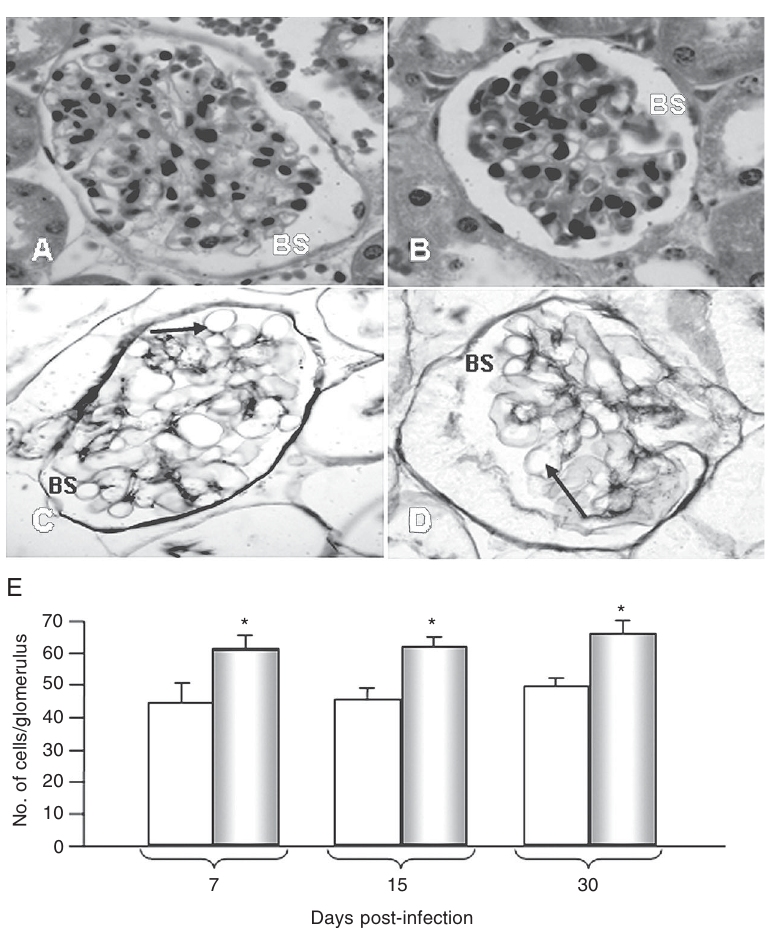
Figure 1. Kidney sections stained with hematoxylin-eosin. A , Glomerulonephritis in BALB/c mice infected with Leishmania ( L. ) chagasi. Hypercellularity in infected mice with glomeru- lar tuft occupying almost the whole Bowman space (BS) (40X). B , Normal cells in glomeruli from control non-infected mice (20X). Kidney stained with periodic acid methenamine silver (40X). C , Glomerulonephritis in BALB/c mice infected with L. ( L. ) chagasi. Hypercellularity in glomerulonephritis and normal glomerular capillary wall (arrow) in infected mice. D , Normal cellularity in glomeruli of a control non-infected mouse. E , Cell number per glo- merulus (mean ± SD) in BALB/c mice non-infected (N = 4) and infected with L. ( L. ) chagasi (N = 8) at 7, 15, and 30 days post-infection. Non-infected = open columns; infected = filled columns. *P < 0.05 compared to non-infected control (ANOVA on ranks and Student- Newman-Keuls